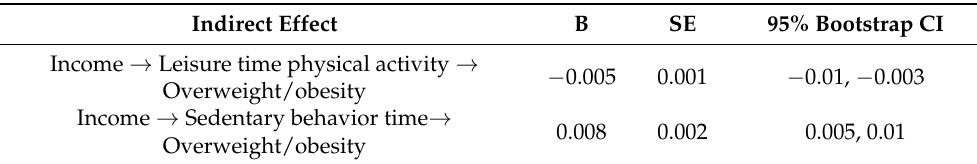
Table 2. Indirect effect of leisure time physical activity and sedentary behavior time on the association between income and overweight/obesity ( n =